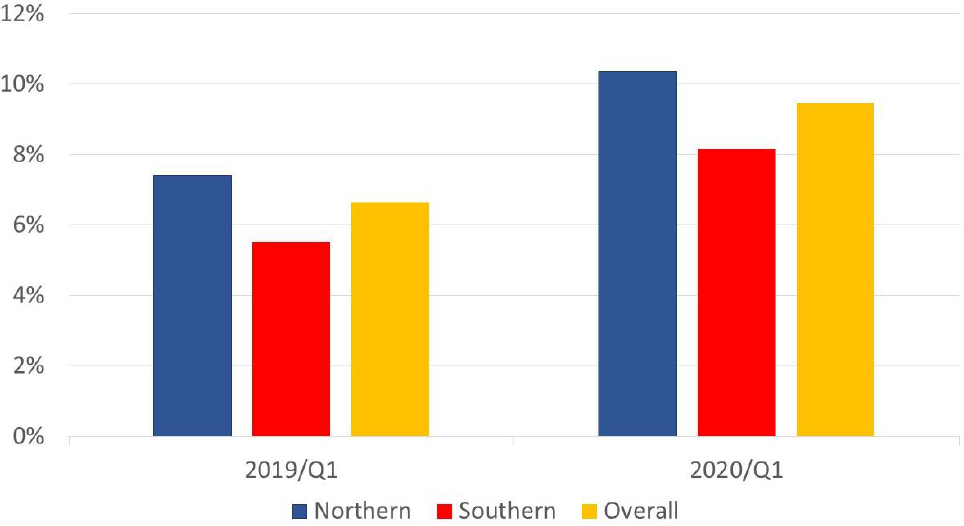
Figure 4. Comparison of the proportion of acute ischemic stroke patients receiving IV-tPA in Q1 2019 vs. Q1 2020.